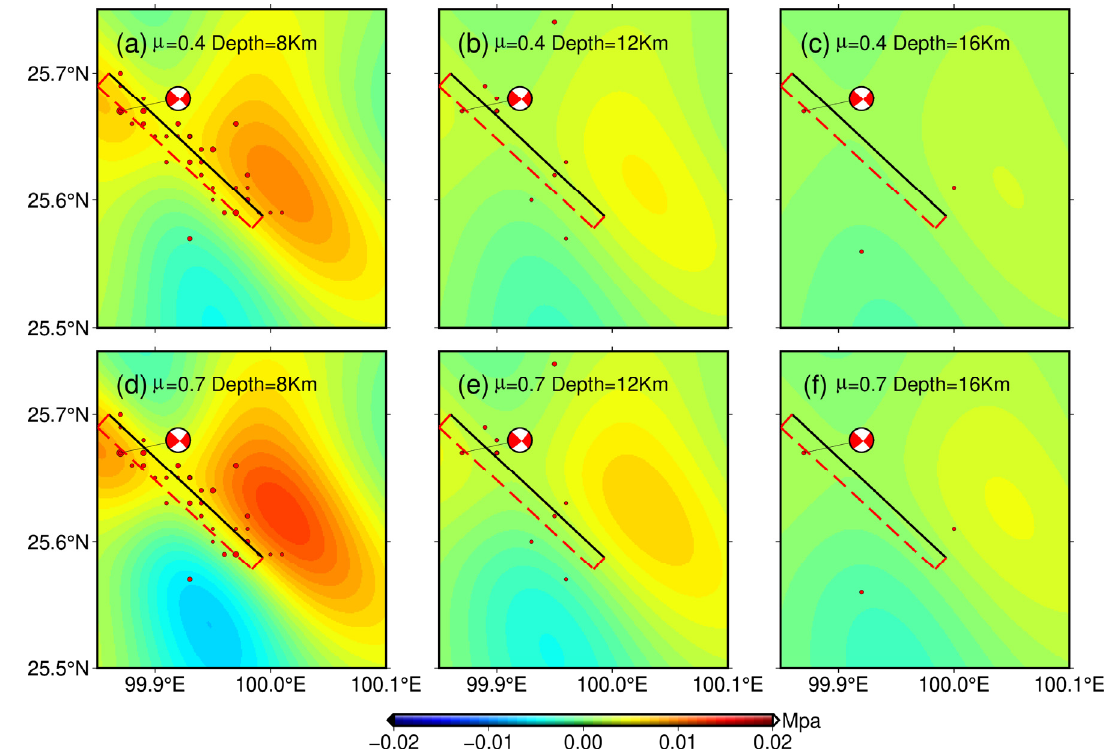
Figure 9. Influence on aftershocks of the static Coulomb stress change caused by the 2021 Ms 6.4 earthquake. The red circles ( a )–( f ) indicate aftershocks. ( a ) and ( d ) show the aftershocks at depths 0~8 km; ( b ) and ( e ) show the aftershocks at depths 8~13 km; ( c ) and ( f ) show the aftershocks deeper than 13 km. The red beach ball diagram and rectangular box represent the source and the receiver fault, respectively.